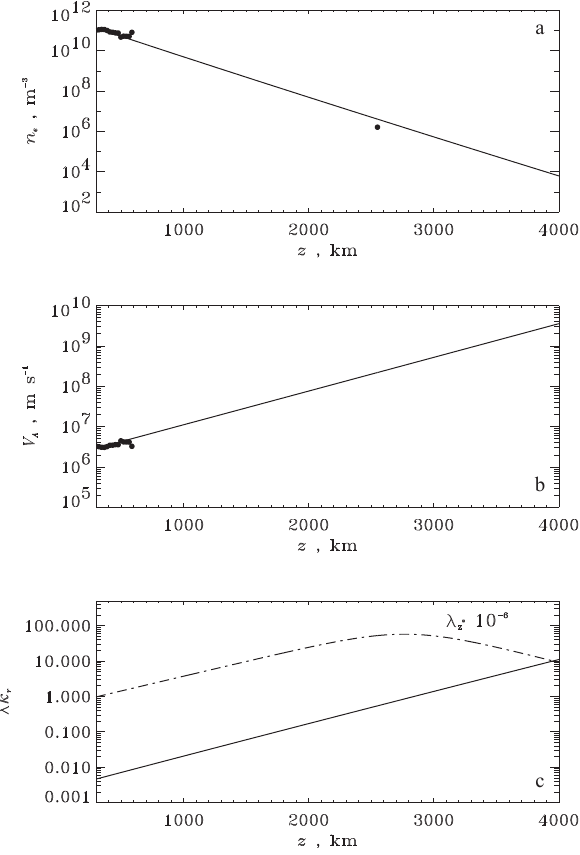
Fig. 6. Variation with altitude of ( a ) electron density n e : (i) which corresponds to the exponential profile of the Alfv´en speed with h = 260km (solid line), (ii) measured by the EISCAT radar between 300 and 600km (filled circles) and density of warm electron population which is estimated from the FAST observations at 2550km (filled circle); ( b ) Alfv´en speed given by an exponential law (solid line) with h = 260km, which fits the observational points between 300 and 600km (filled circles); ( c ) longitudinal wavelength (dashed- dotted line) and λk r (solid line) as deduced from the dispersion Eqs. (38),